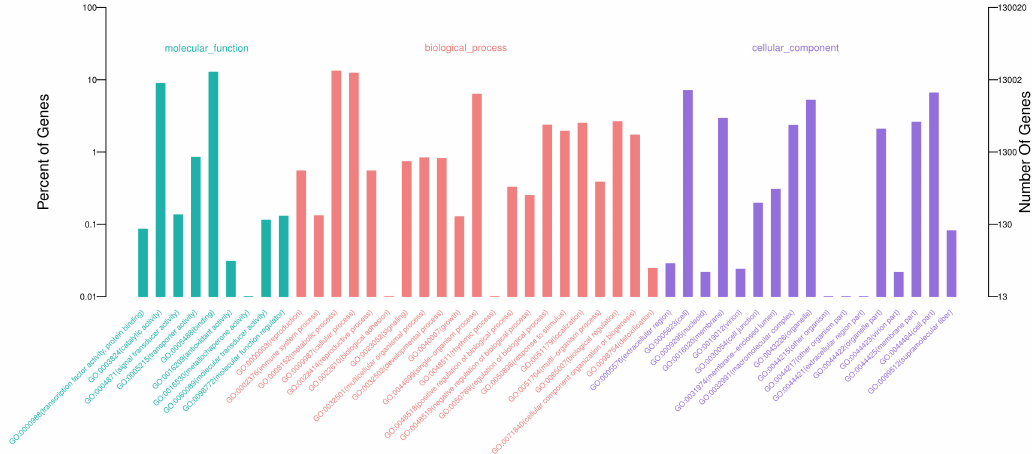
Figure 2. Gene Ontology (GO) classifications for the assembled